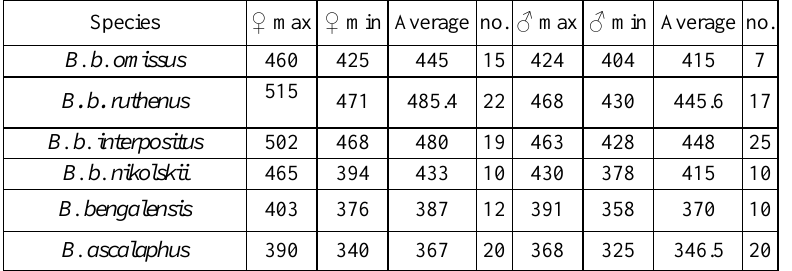
Table (1): Wing measurements (in mm) of four Bubo bubo subspecies, Bubo bengalensis , and Bubo ascalaphus. Compiled from Dement’ev et al. (1951), Vaurie (1965), and Weick